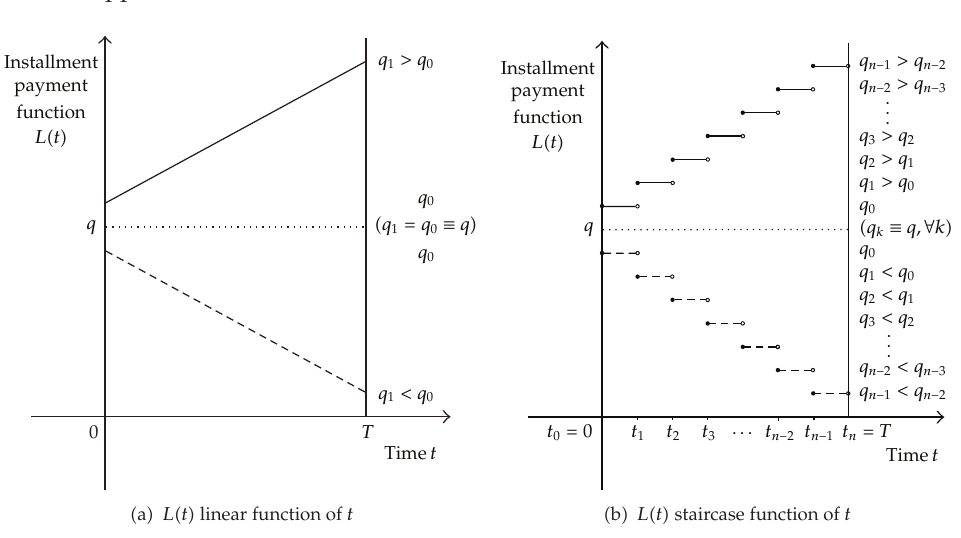
Figure 5: Examples of time-varying payment